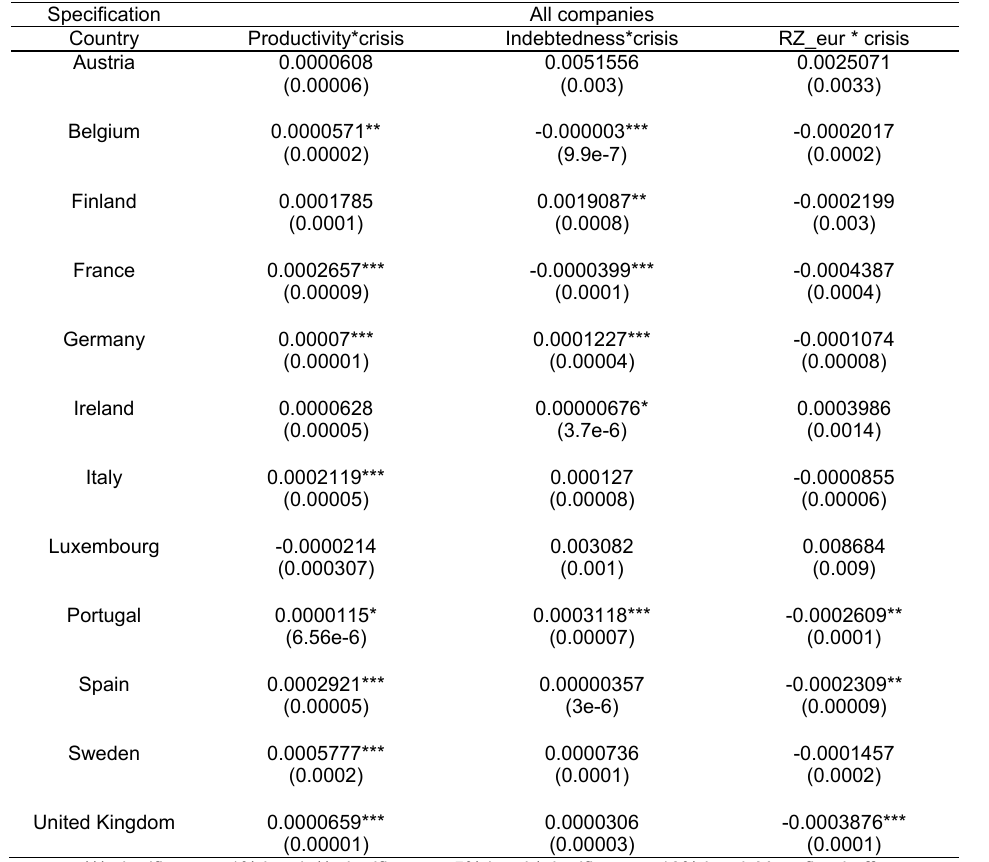
Table A.4. Cross-country effects (all